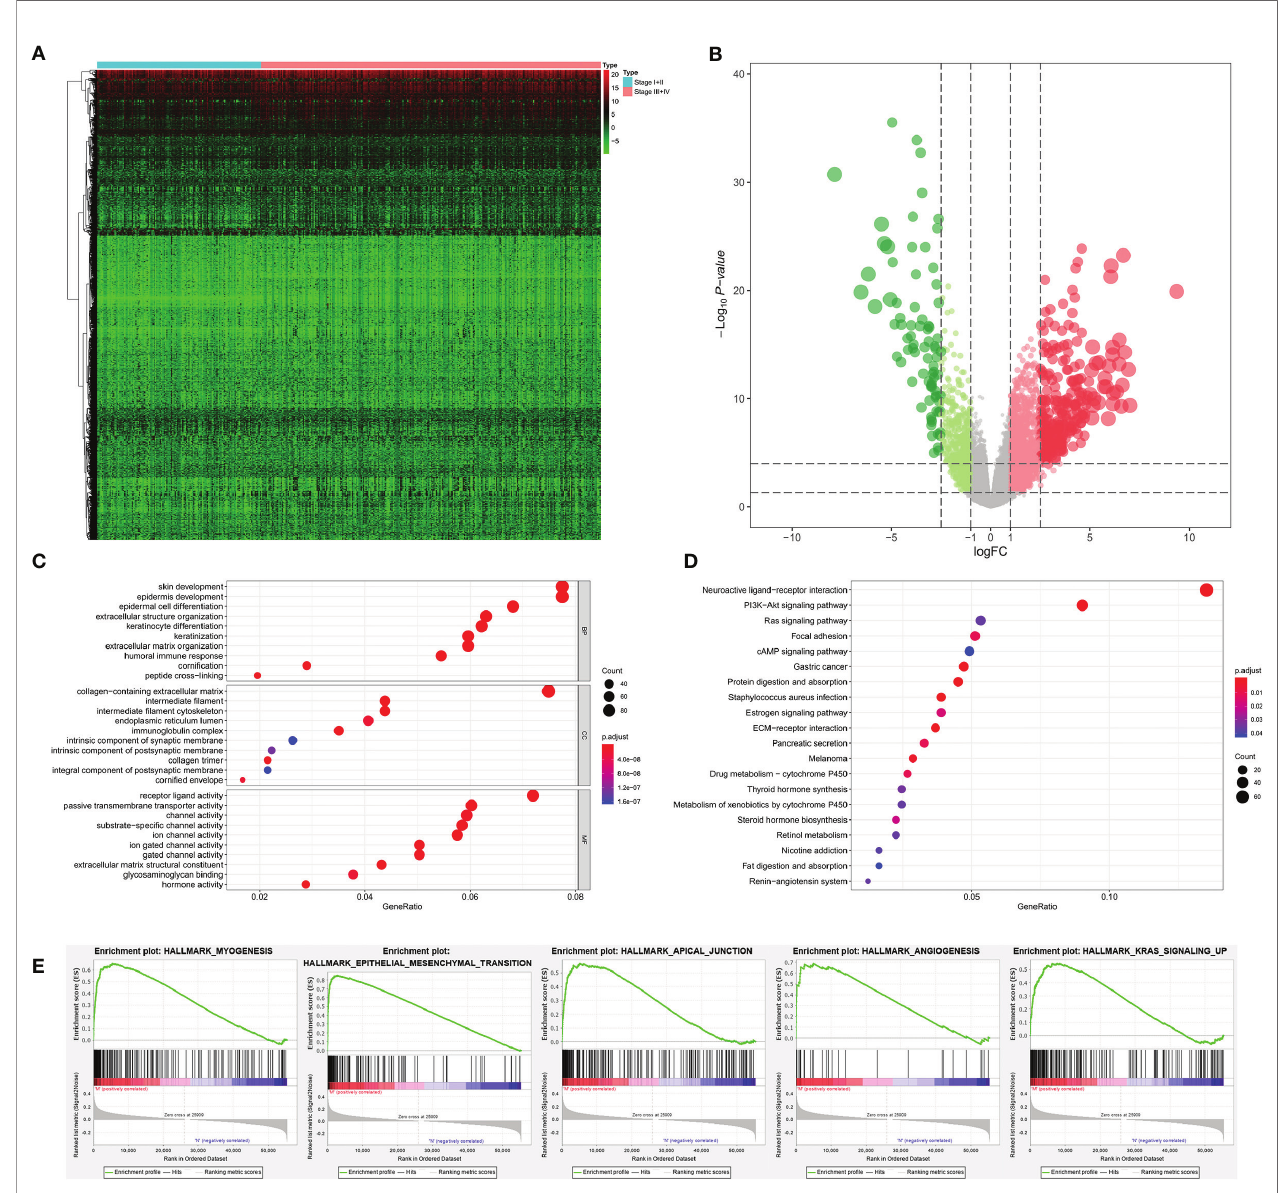
FIGURE 3 | The results of differential expression genes analysis and functional enrichment analysis between Stage I or II BLCAs and Stage III or IV BLCAs: The heatmap (A) and volcano plot (B) of the differential expressed genes. The GO (C) , KEGG (D) , and (E) top fi ve GSEA enriched terms for the differential expressed